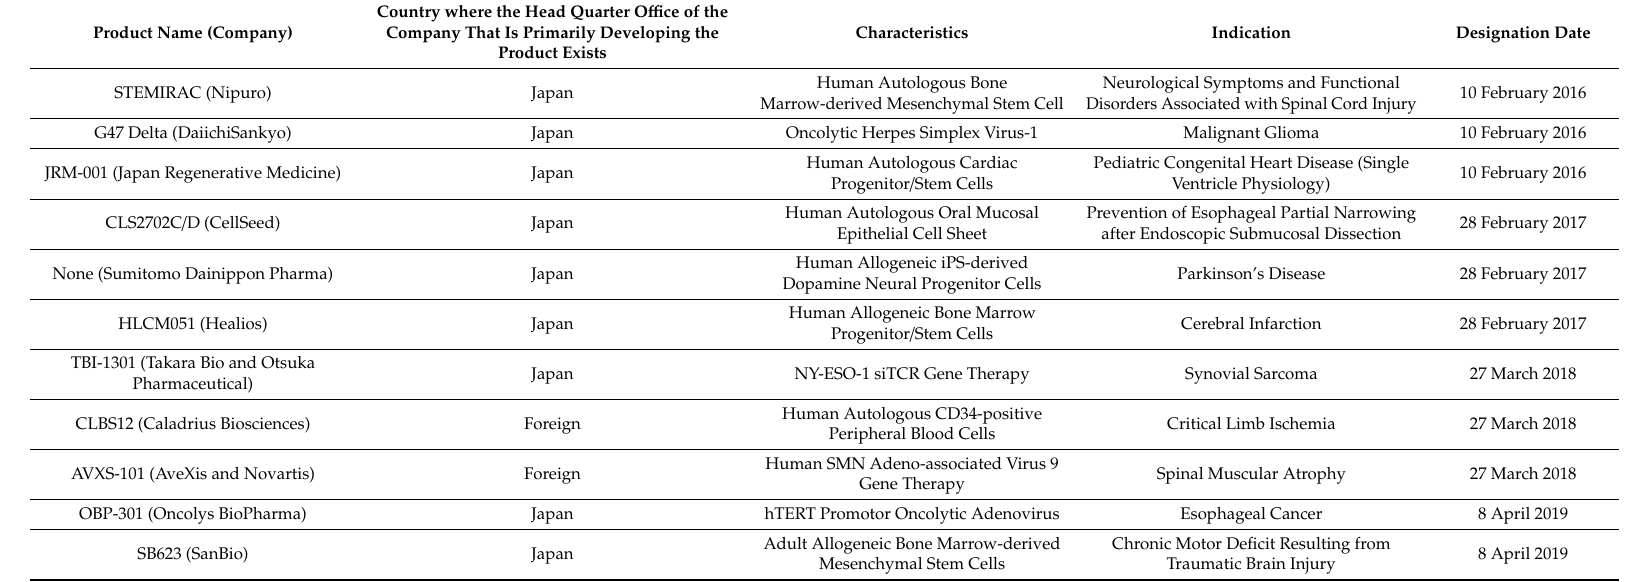
Table 11. Sakigake-designated regenerative medical products in Japan as of 31 May